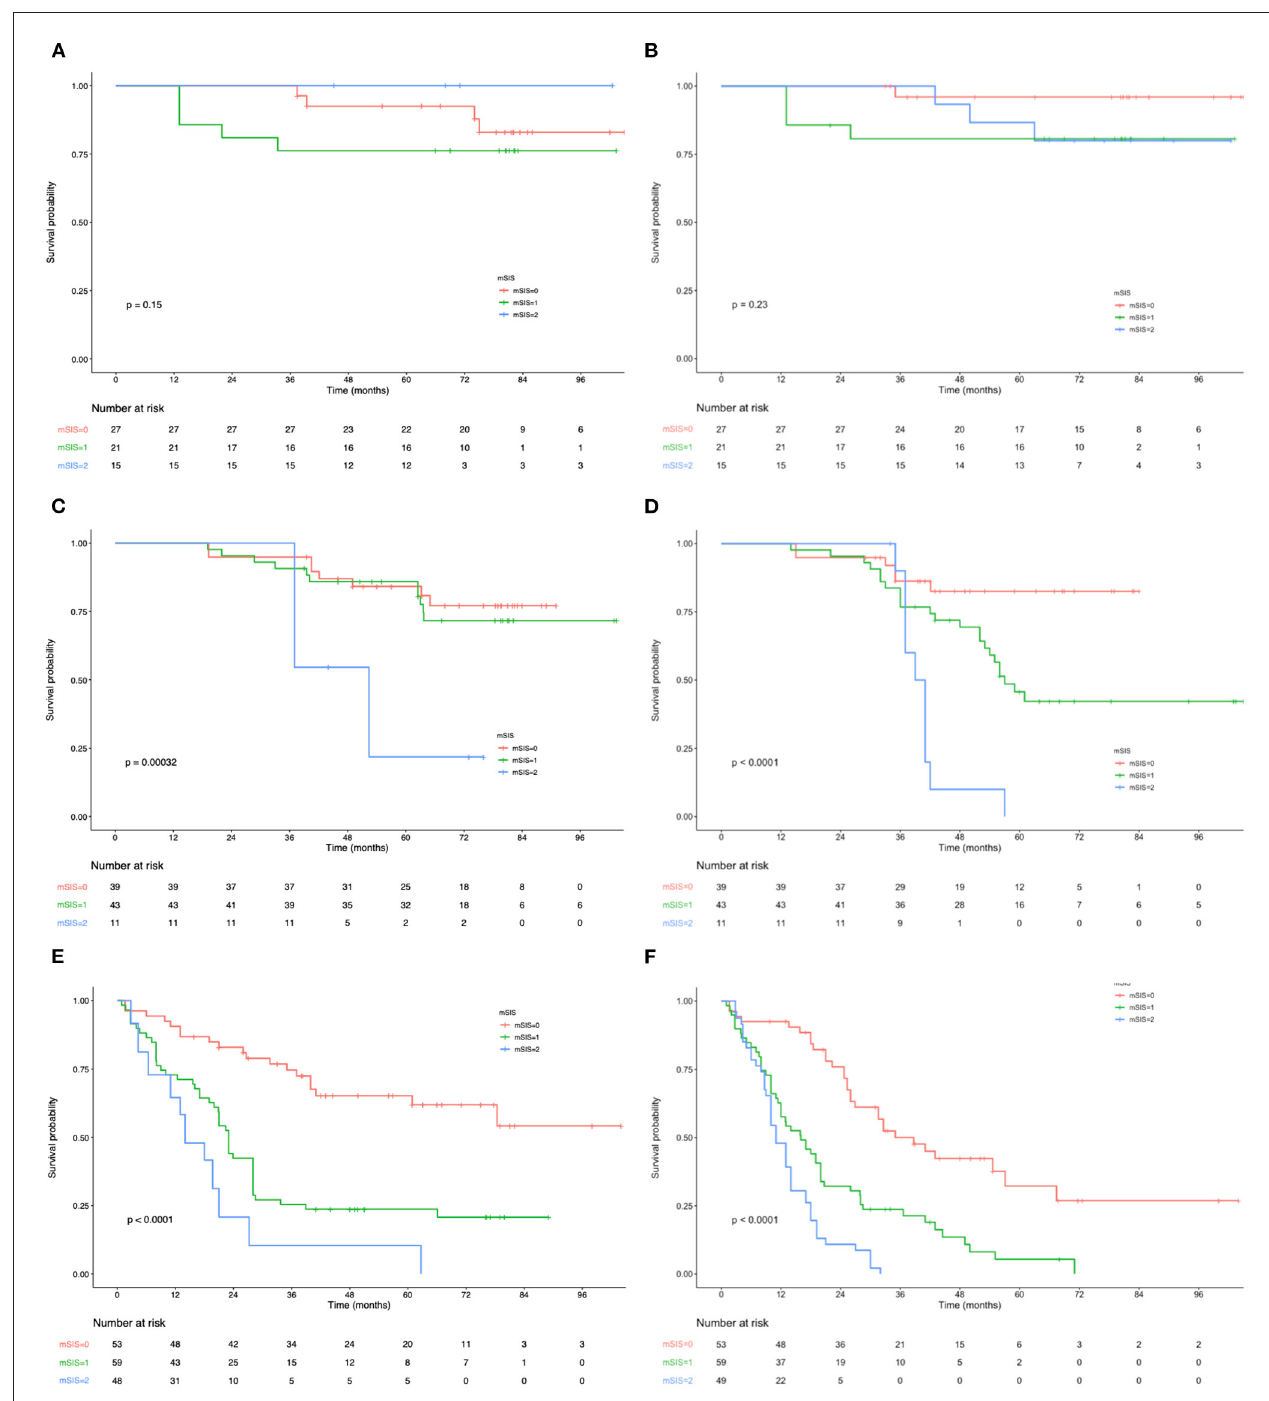
FIGURE 2 | (A) Relationship between mSIS and the OS of patients with stage I AEJ. (B) Relationship between mSIS and the RFS of patients with stage I AEJ. (C) Relationship between mSIS and the OS of patients with stage II AEJ. (D) Relationship between mSIS and the RFS of patients with stage II AEJ. (E) Relationship between mSIS and the OS of patients with stage III AEJ. (F) Relationship between mSIS and the RFS of patients with stage III AEJ. OS, overall survival. RFS, relapse-free survival. AEG, adenocarcinoma of the gastroesophageal junction. mSIS, modified systemic inflammation score.